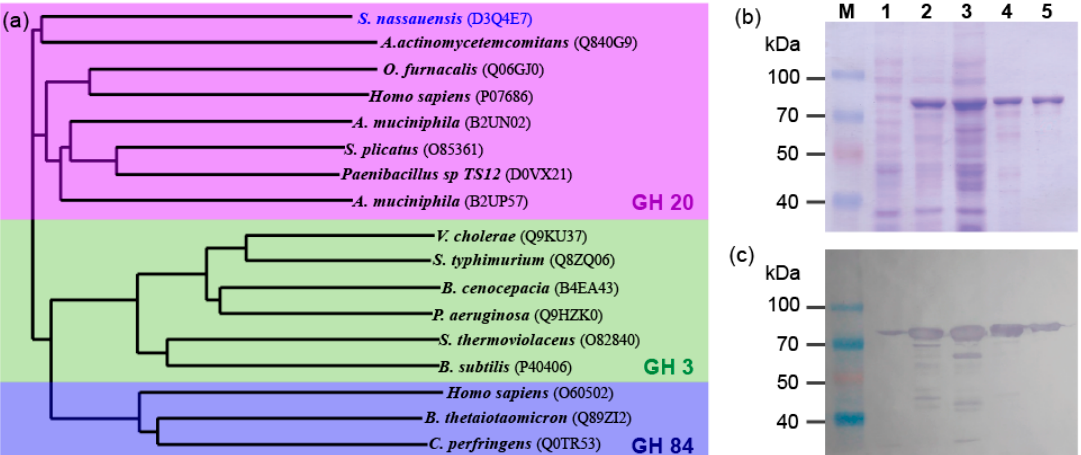
Figure 1. ( a ) Schematic representation of the phylogenetic relationship of functionally characterized β - N -acetylhexosaminidases (UniProt identifiers shown in parentheses). ( b ) SDS-PAGE analysis and ( c ) Western blotting (using anti-polyHistidine antibody) of recombinant SnHex at various stages of expression and purification. M—protein marker, 1—cell pellet before induction, 2—cell pellet